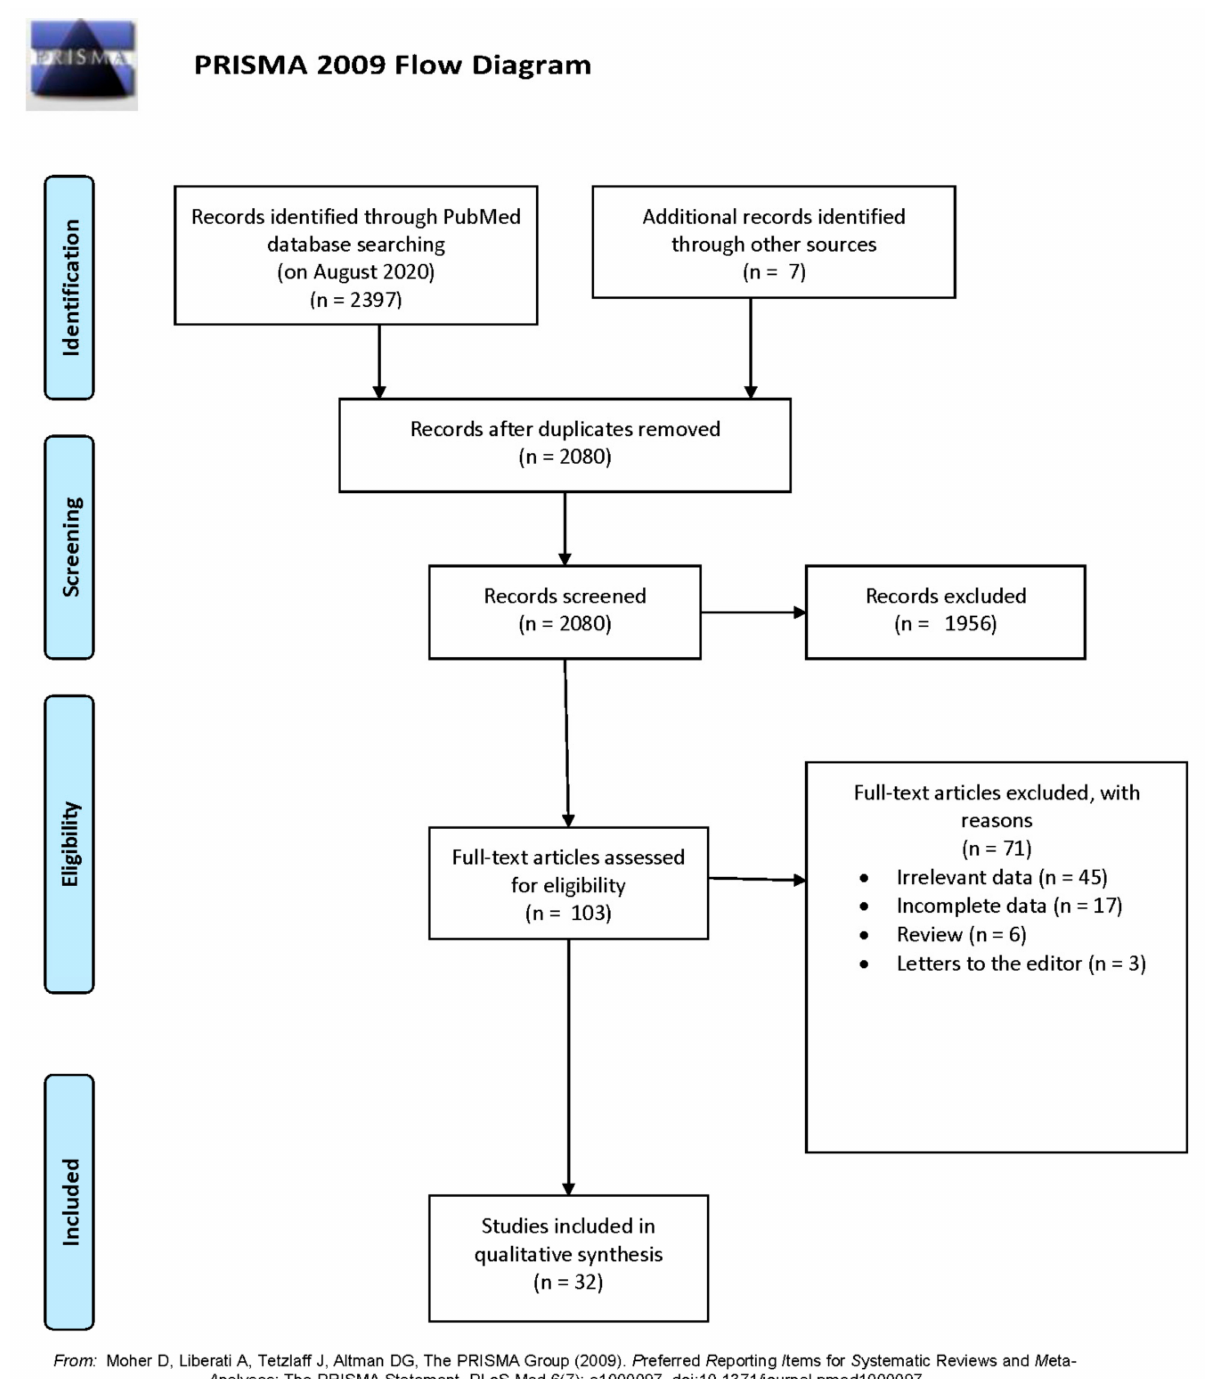
Figure 1. Flow-chart of systematic